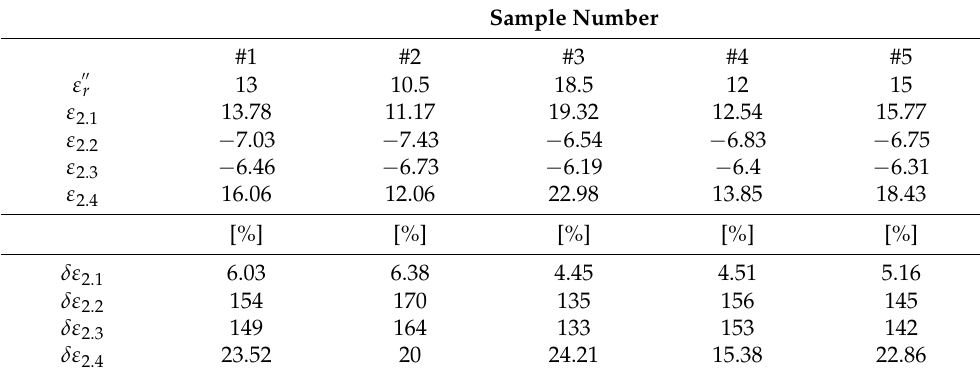
Table 3. The initial results of permittivity